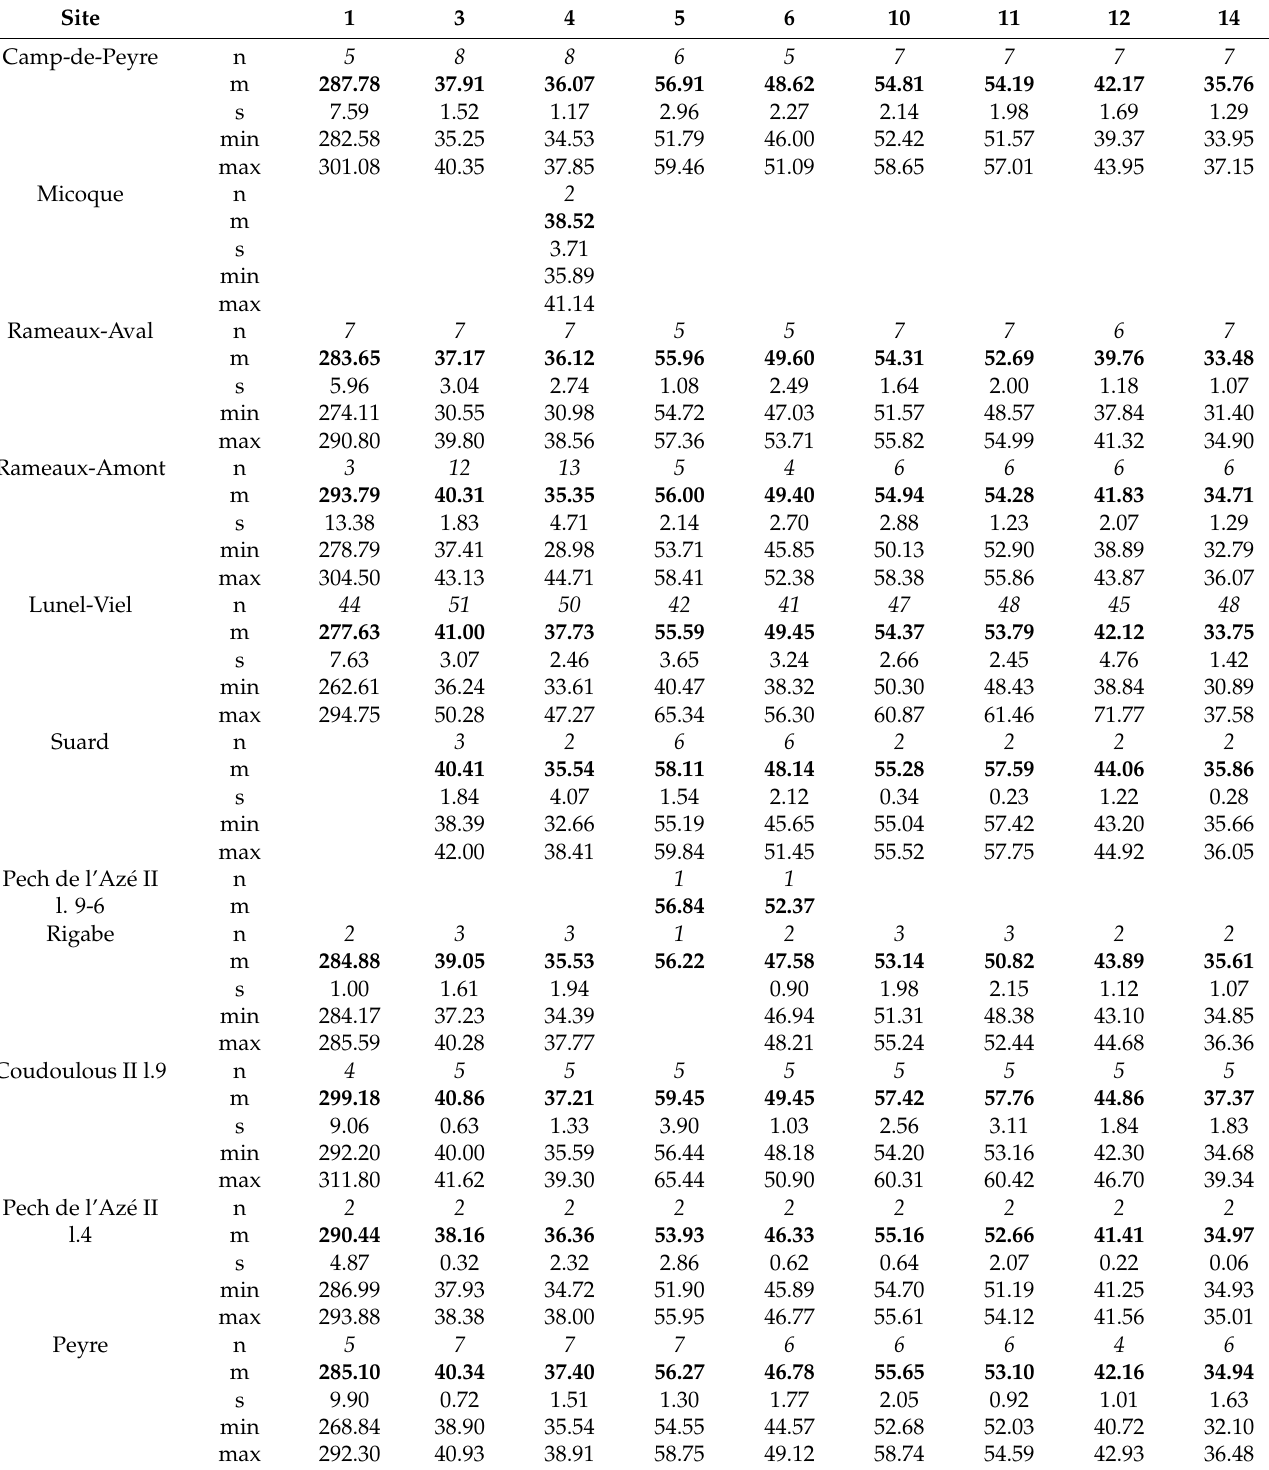
Table 4. Measurements in millimetres of the third metatarsals of horses from the caballoid lineage. 1: Maximal length; 3: Breadth at the middle of the diaphysis; 4: Depth of the diaphysis at the same level; 5: Proximal breadth; 6: Proximal depth; 10: Distal supra-articular breadth; 11: Distal articular breadth; 12: Depth of the sagittal crest; 14: Greatest depth of the medial condyle (measurements from V. Eisenmann [76]). n= number of specimens; m=mean; s=standard deviation; min-max: minimal and maximal values. Camp-de-Peyre: E. m. campdepeyri ; La Micoque: E. mosbachensis ; Rameaux-Aval and Amont: E. mosbachensis ; Lunel-Viel: E. m. palustris ; Suard: E. caballus piveteaui ; Pech de l’Az é II l.9-6: E. mosbachensis ; Rigabe: E. m. palustris ; Coudoulous II l.9: E. mosbachensis ; Pech de l’Az é II l.4: E. caballus ; Peyre: E. caballus .